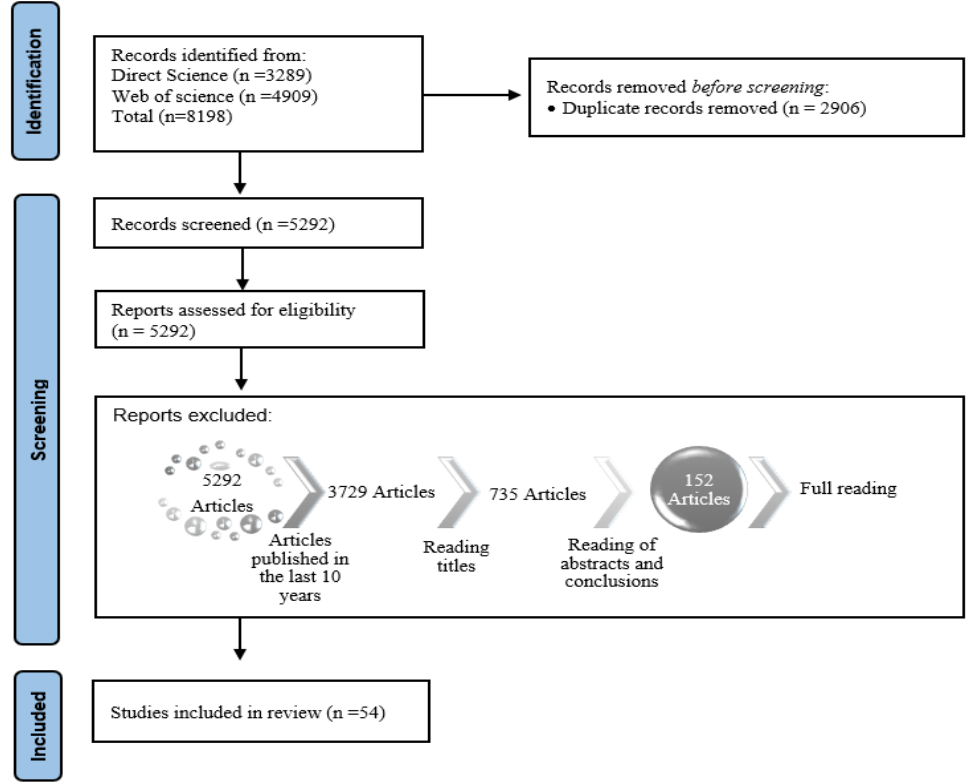
Figure 2. Diagram of analysis based on the PRISMA statement.